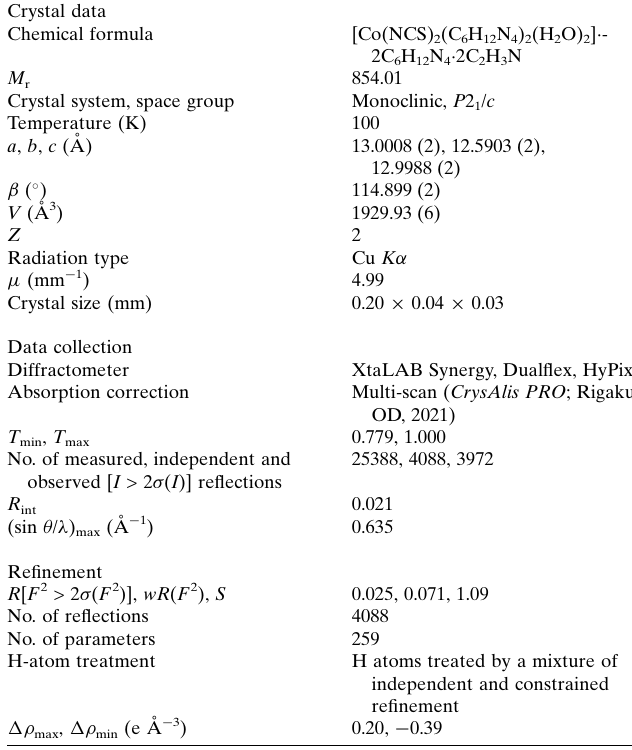
Table 3 Experimental details. Crystal data Chemical